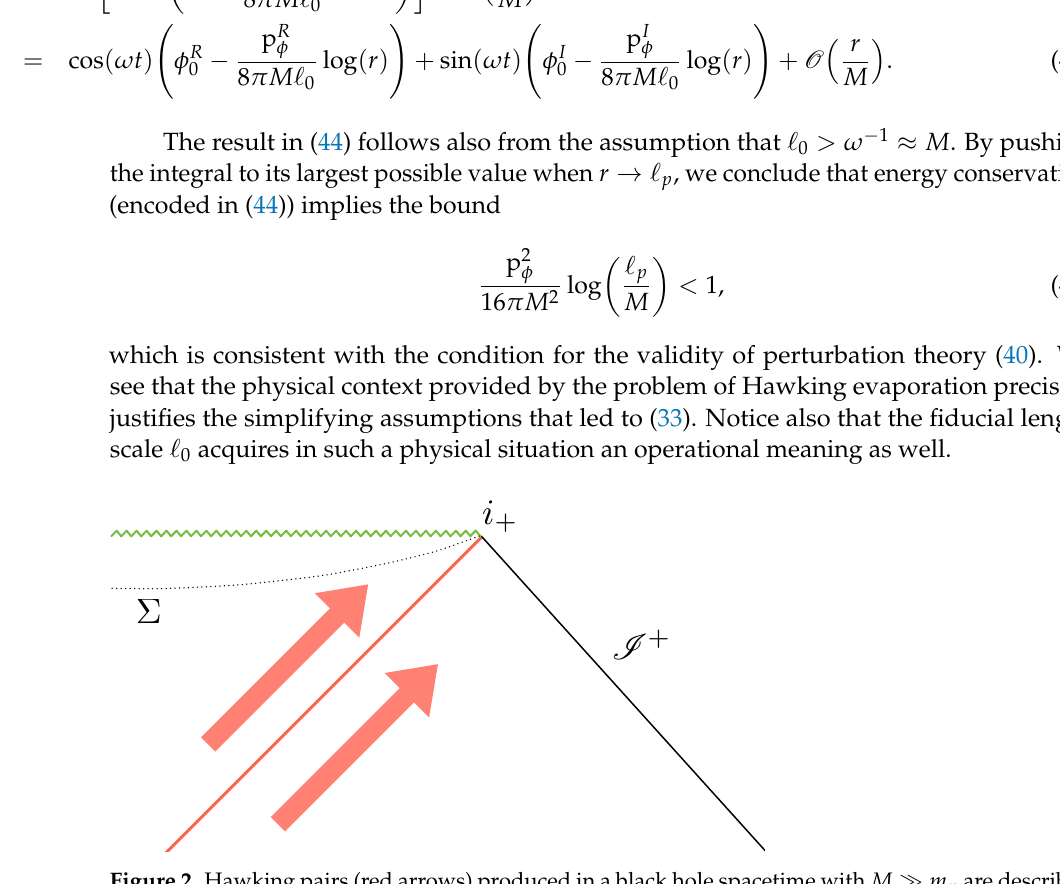
Figure 2. Hawking pairs (red arrows) produced in a black hole spacetime with M (cid:29) m p are described as test field excitations on a background spacetime that is idealized by a stationary black hole solution in the region of the Penrose diagram away from the collapsing matter and containing i + . Stationarity implies the existence of a conserved energy-momentum current used, in this paper, to relate the value of p φ in the KS model to the frequency of the emitted particle at I + and (via Hawking temperature) to the black hole mass M . The surface Σ represents an r =constant surface in the interior (denoted Σ r in the main